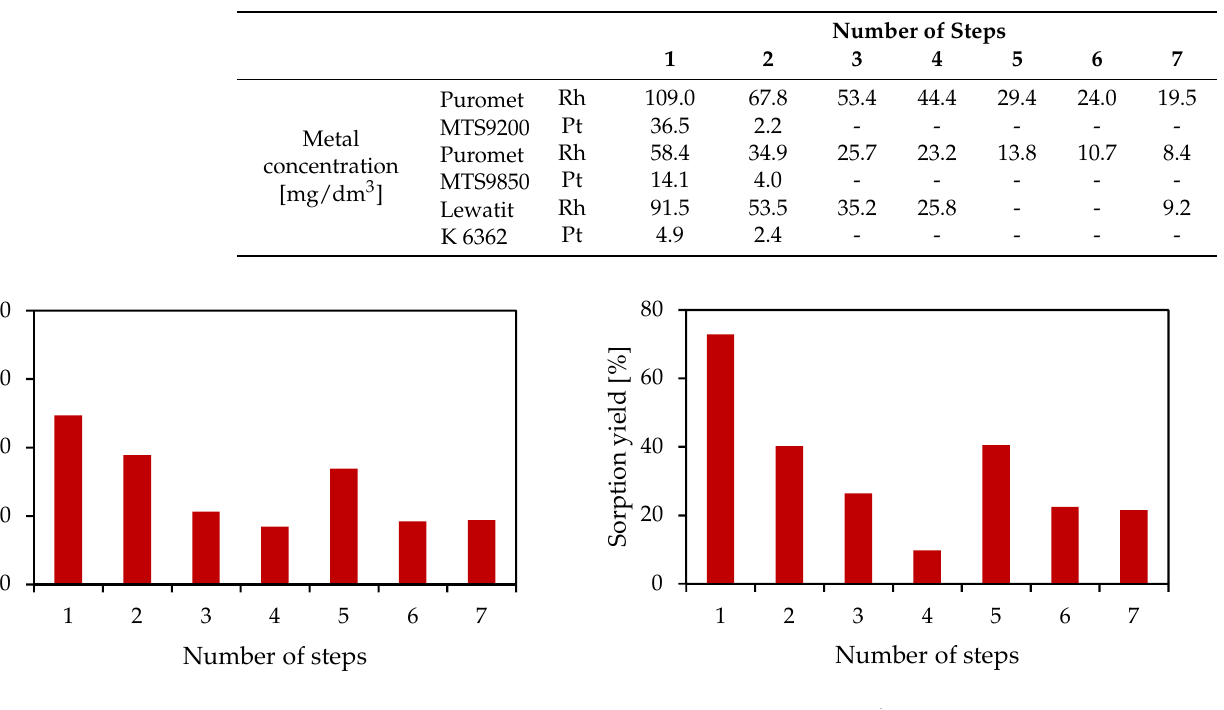
Table 5. Concentration of Rh and Pt in the post-process solution depending on the number of sorption steps.